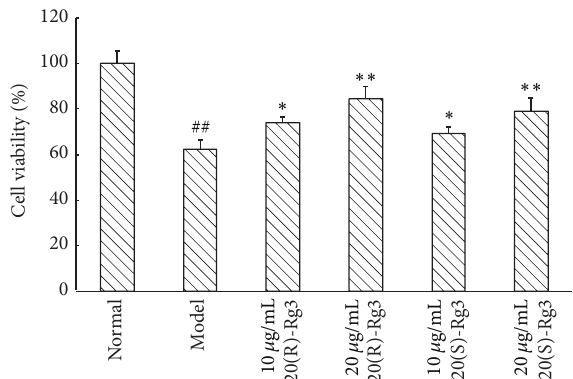
Figure 4: Protective effect of ginsenoside Rg3 on SK-N-SH cells by MTT assay. ## 𝑃 < 0.01 versus normal group, ∗ 𝑃 < 0.05 , and ∗∗ 𝑃 < 0.01 versus model group.